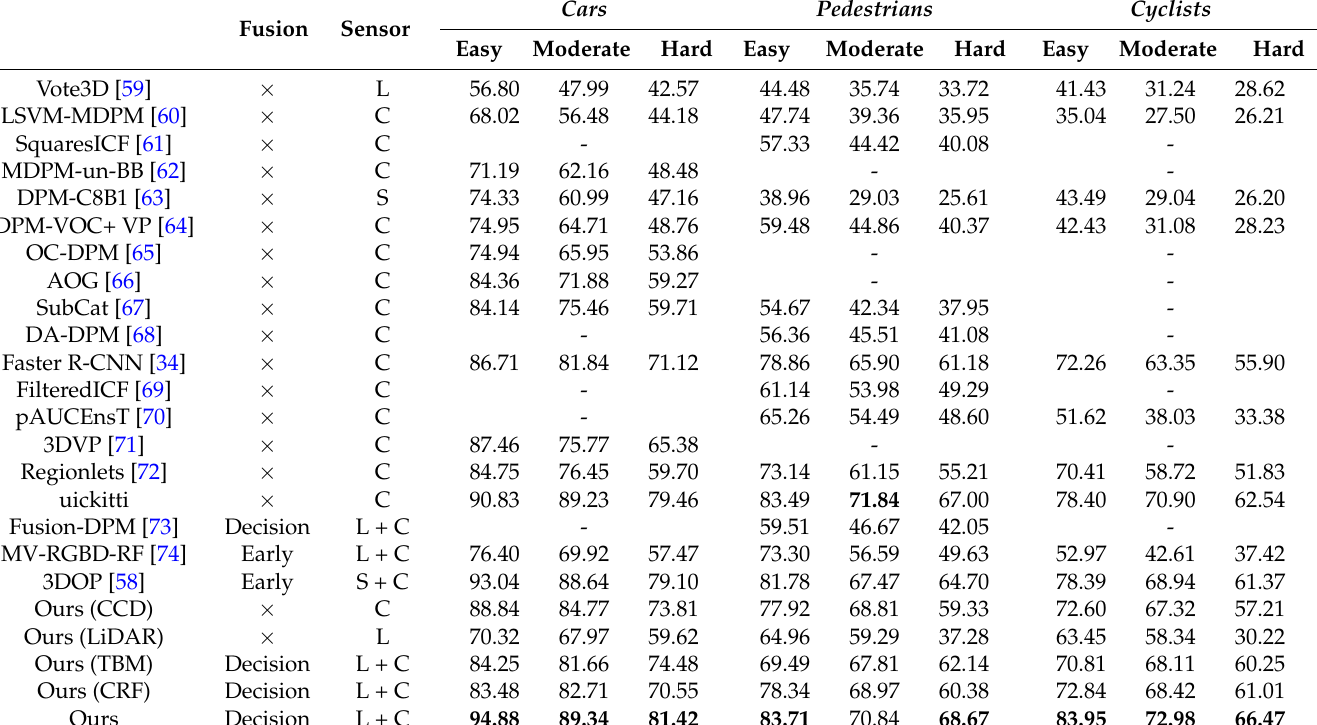
Table 5. Average precision (AP) (%) of the KITTI Object Detection Benchmark dataset. L, C and S in the “Sensor” column denote the LiDAR, CCD and stereo